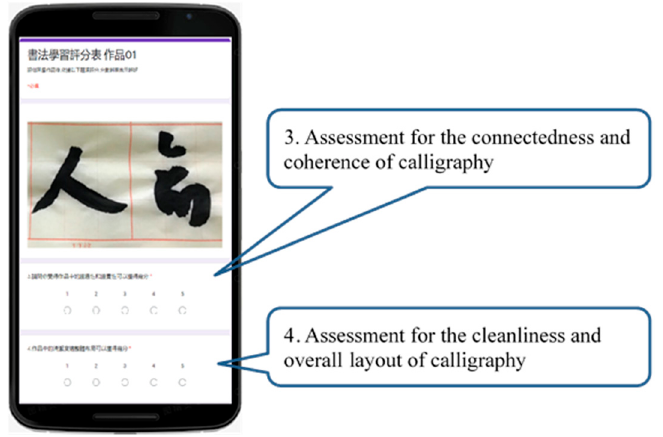
Figure 5. Screenshots of peer assessment items on participants’ mobile phones.